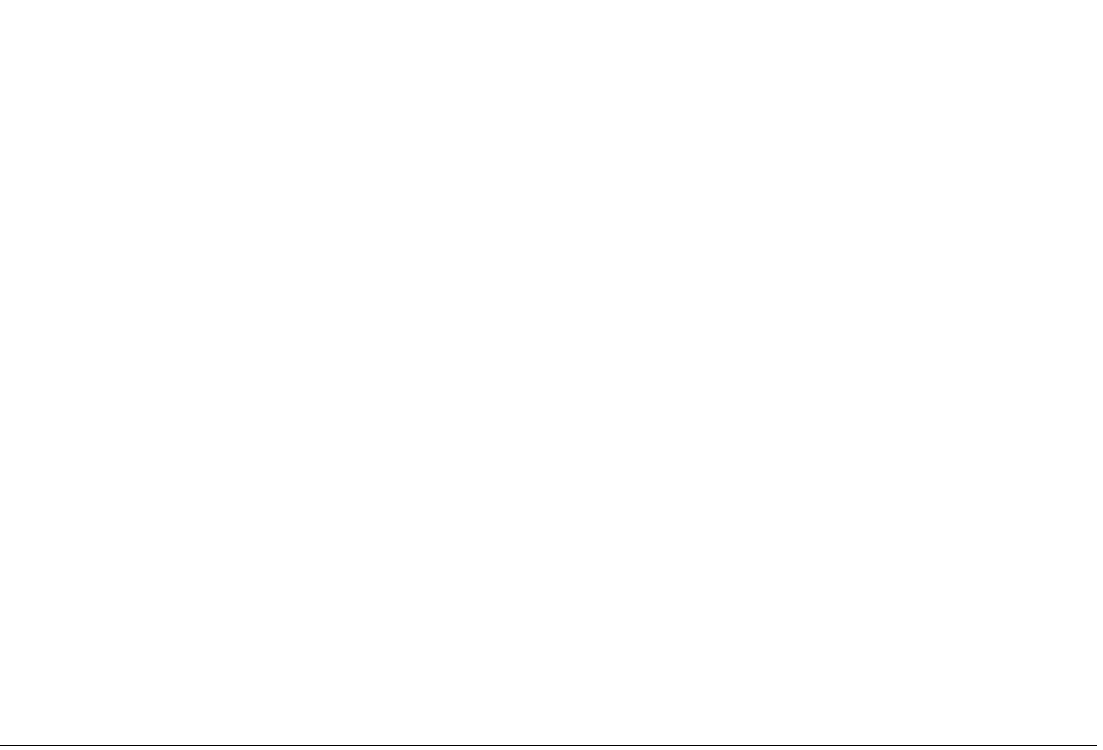
Figure 11. ( a–c ) Present P@H = 2 on three datasets. (Created by “matlab R2019a” url: https:// ww2. mathw orks. cn/ produ cts/ matlab.